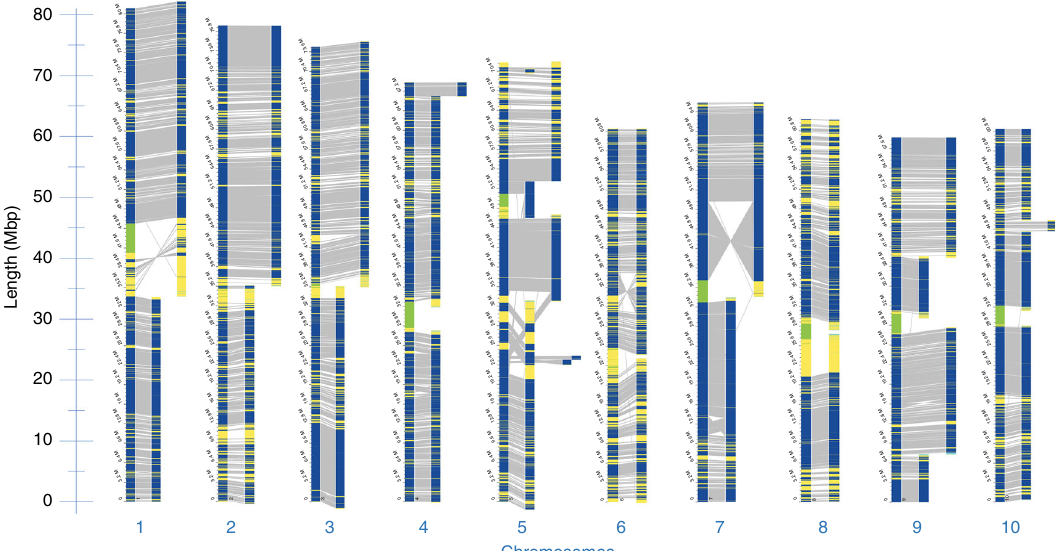
Fig. 2 Alignment of Tx430 maps against in-silico maps of the BTx623 reference assembly. Collinear DLE-1 markers on the two maps are linked (gray lines). All but three chromosomes are captured by two DLS maps. Large inversions are shown on chromosomes 6 and 7. Regions in green are stretches of random nucleotides in the reference assembly. Regions in yellow exhibit breaks in collinearity between the two maps